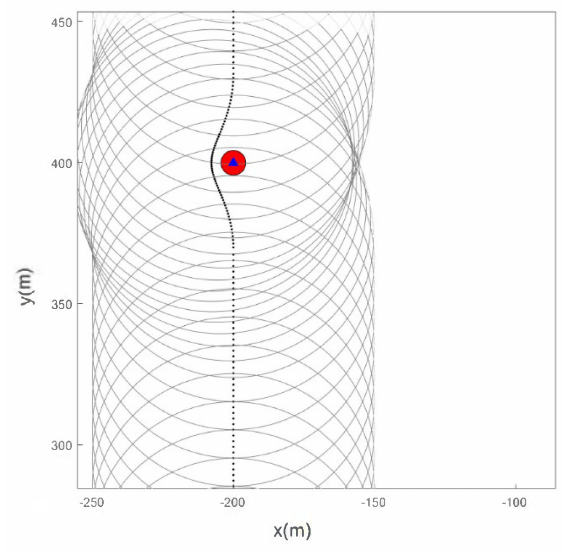
Figure 5. Sensor avoidance.